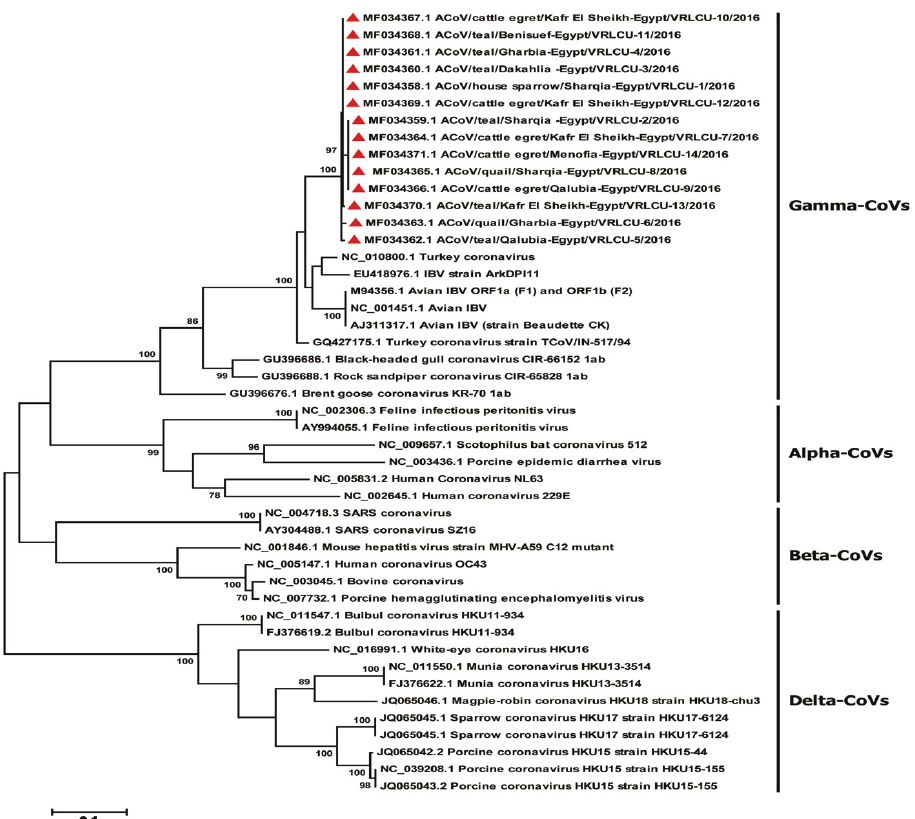
Figure 2. Phylogenetic tree based on the RdRp gene, showing that the detected viruses in this study belonged to gamma-coronaviruses. Trees constructed using maximum likelihood methods. The reported isolates in this study are marked with red triangular.